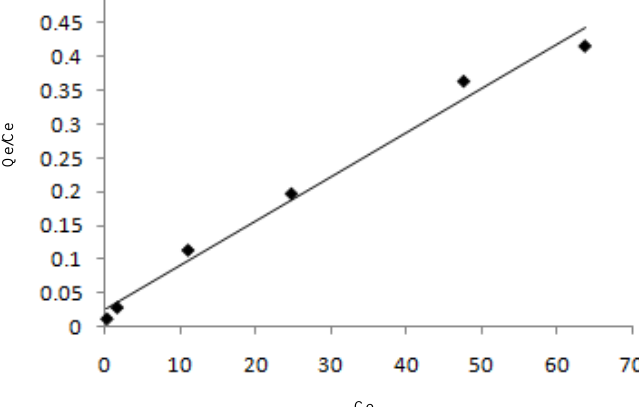
Figure 8. Langmuir isotherm for adsorption data of AR18 by MWCNTs; Time 120 min, dose: 0.04 g/100 mL, pH=7.